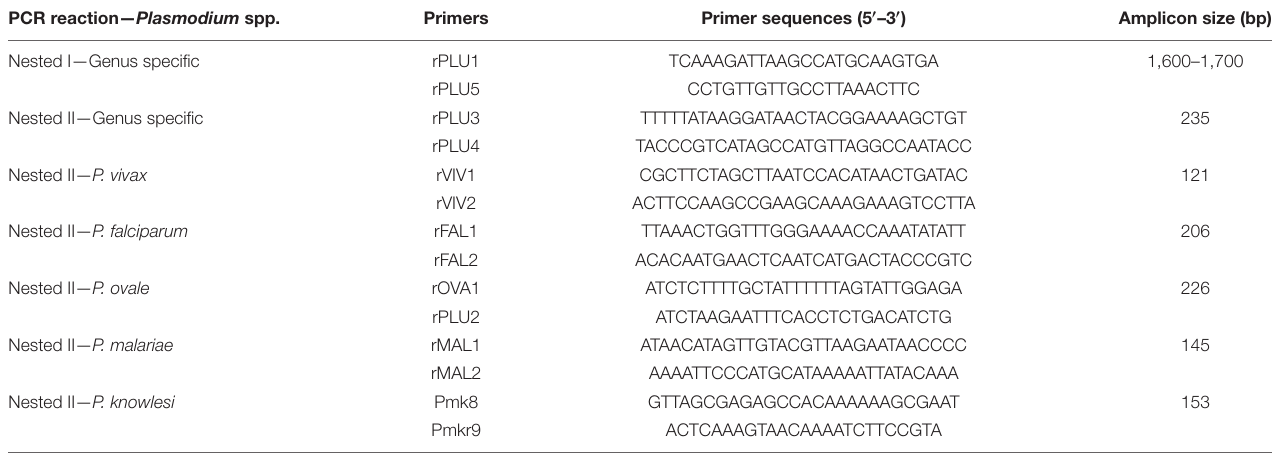
TABLE 1 | Primer sequences used in this study for PCR detection of malaria parasites. PCR reaction— Plasmodium